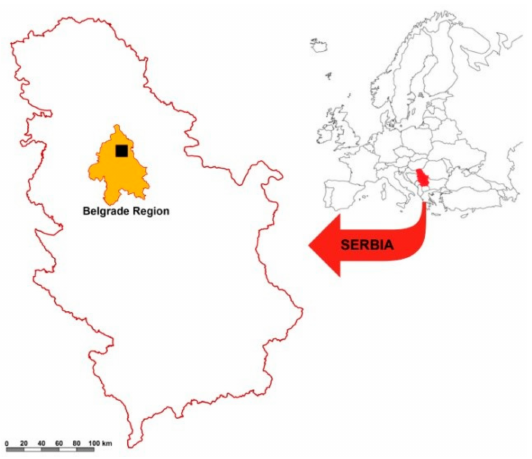
Figure 2. Study area